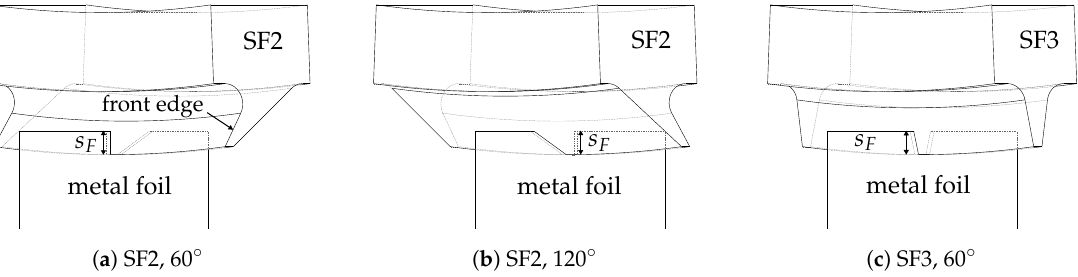
Figure 4. Geometrical contact conditions for the inclined seal fin (SF2) in 60 ◦ and 120 ◦ configuration, the perpendicular seal fin